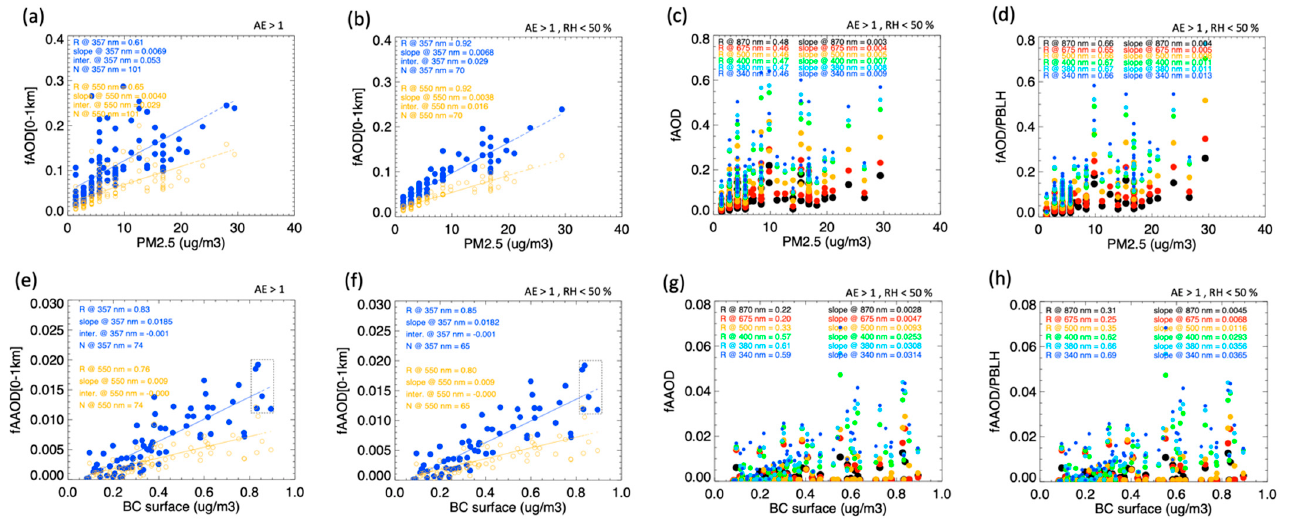
Figure 5. Scatter plots of the observed PM2.5 surface concentrations and fAOD[0–1 km] values of the partial column below 1 km ( a , b ), surface BC concentrations and fAAOD[0–1 km] values of the partial column ( e , f ), PM2.5 concentrations and fAOD (i.e., total column) ( c ), and BC concentrations and fAAOD (i.e., total column) ( g ). Panels ( d , h ) are identical to ( c ) and ( g ), except the fAOD and fAAOD values are divided by the boundary layer altitude. Only days with an AE > 1 and low RH were used (as indicated in the top-right corner of each panel). Statistics are included in each panel. The dashed box in ( e,f ) highlights the days with the largest BC concentrations; their backward trajectories are shown in Figure 1.